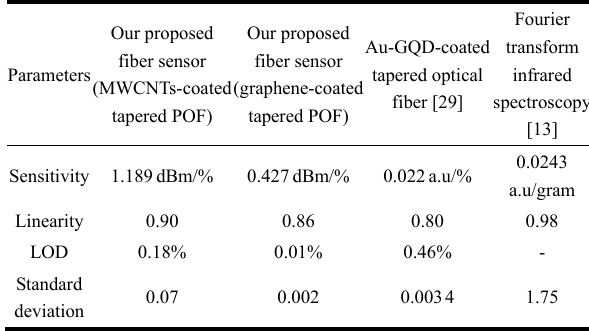
Fig. 9 Measurement of stability of the tapered POF with the (a) graphene coating and (b) MWCNTs coating. Table 2 Performance evaluation of the tapered POF with various coating layers.